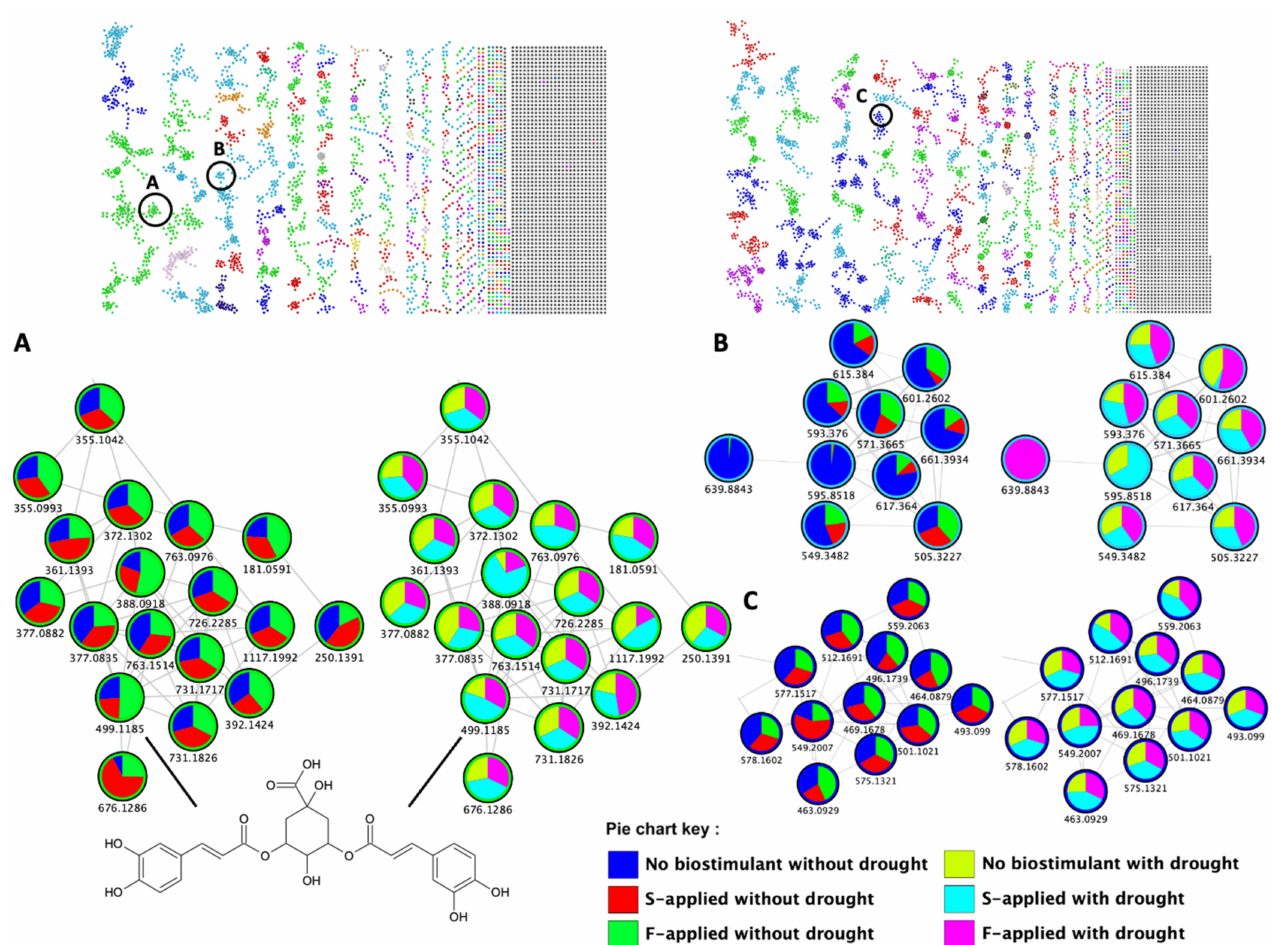
Figure 6. The MolNetEnhancer molecular network of positive electrospray ionization (ESI+) (top left) and negative ESI- MS/MS (top right) spectra obtained from maize leave extracts. The enriched molec- ular networks depict structurally similar nodes as molecular families/clusters, with the annotated metabolites, MS2LDA substructures and NAP annotations assigned class annotations, represented by colored nodes and nodes with no class annotation as grey. The pie charts show the differential effects of the seaweed-based biostimulant treatment and their method of application on the metabolite levels of the ( A ) carboxylic acid and derivatives; ( B ) lipids; and ( C ) flavonoid molecular families under normal and drought stress conditions. Abbreviations: S-applied, soil applied; and F-applied, foliar